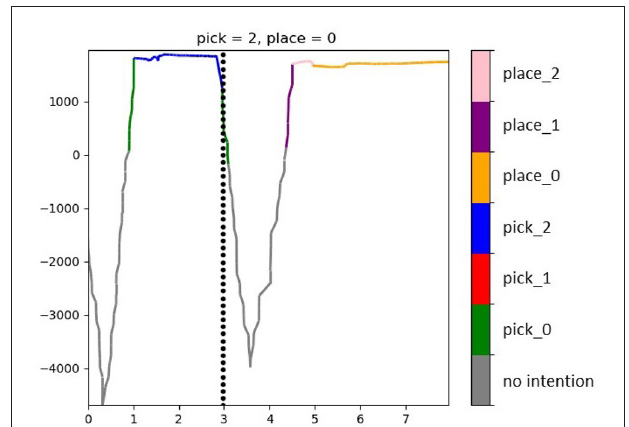
FIGURE 10 | Likelihood of the predicted intention for a trial picking in position 2 and placing in position 0. The black dashed vertical line shows the time of the grasp event. At any time the likelihood of the currently highest model score is depicted in the color associated with the respective intention (see legend). If the highest score is below the threshold κ = 0, no intention is accepted (gray